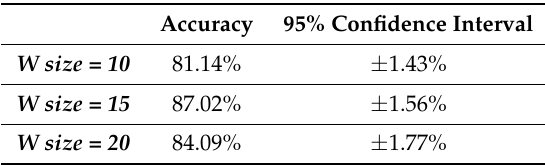
Table 5. Accuracy and confidential interval using different size of observation window W